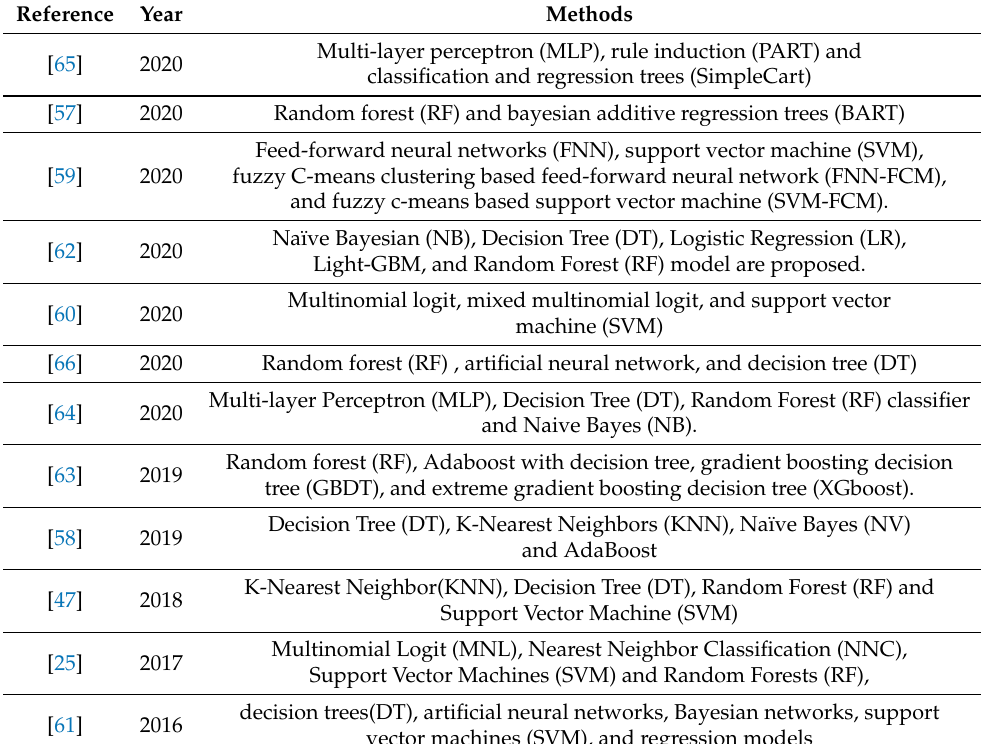
Table 4. Machine learning methods commonly used in